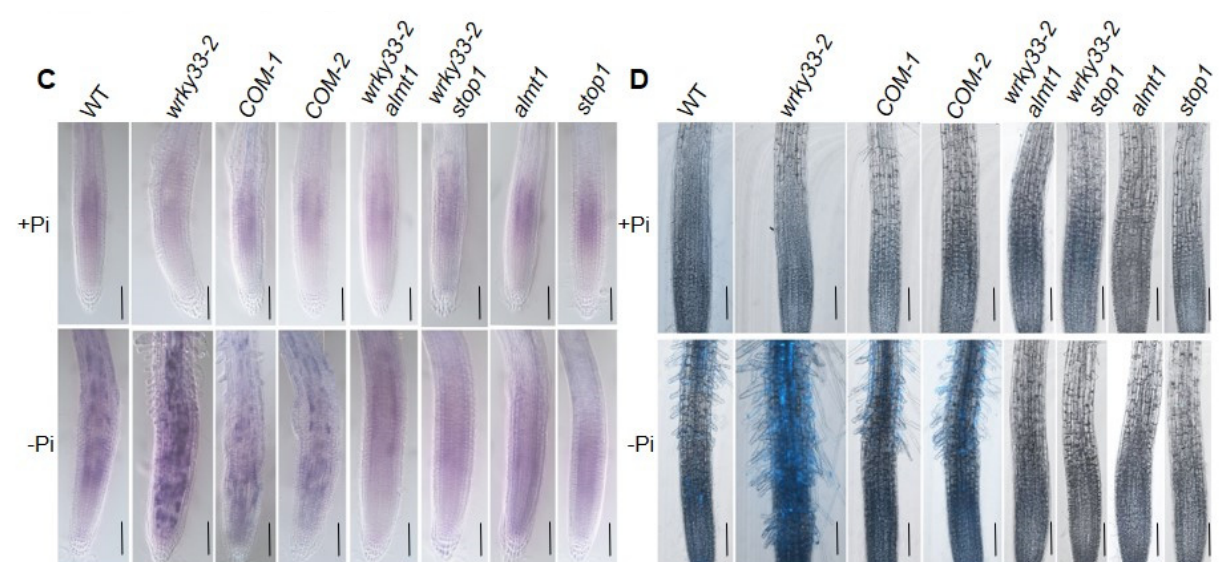
Figure 6. Pi deficiency-induced Fe, ROS, and callose deposition in root apex. ( A , B ) Fe staining by Perls ( A ) and Perls/DAB ( B ). Four-day-old plants grown on +Pi or − Pi medium for three days. The experiments were repeated three times with similar results. Bar = 50 um. ( C ) NBT staining of superoxide (O 2– ) anion in WT and mutant roots. Four-day-old seedlings were transferred to +Pi or − Pi medium for three days; the roots were stained with 1 mM NBT solution for 60 min and photographed under microscopy. Bar = 50 um. ( D ) Aniline blue staining of callose in primary roots after transfer of four-day-old plants to +Pi or − Pi medium for three days. Bar = 50 um.